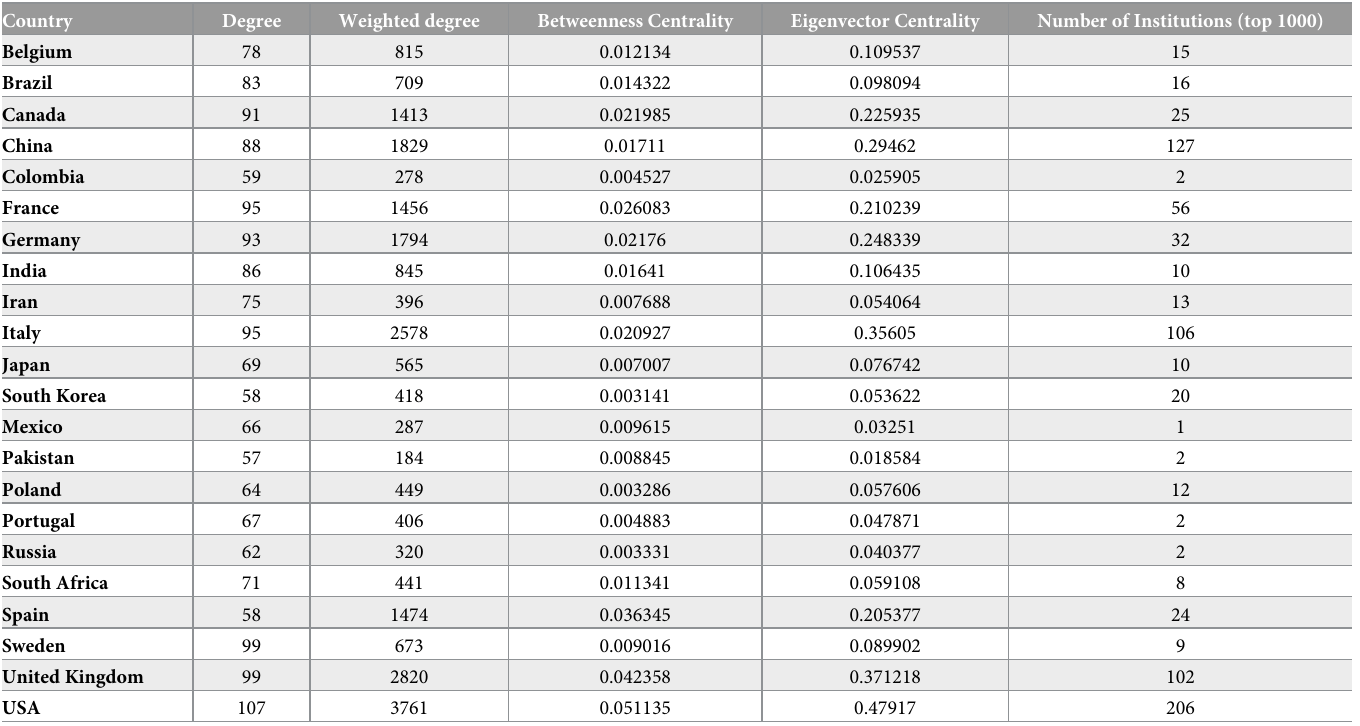
Table 1. Network metrics of scientific collaboration for selected nations during COVID-19